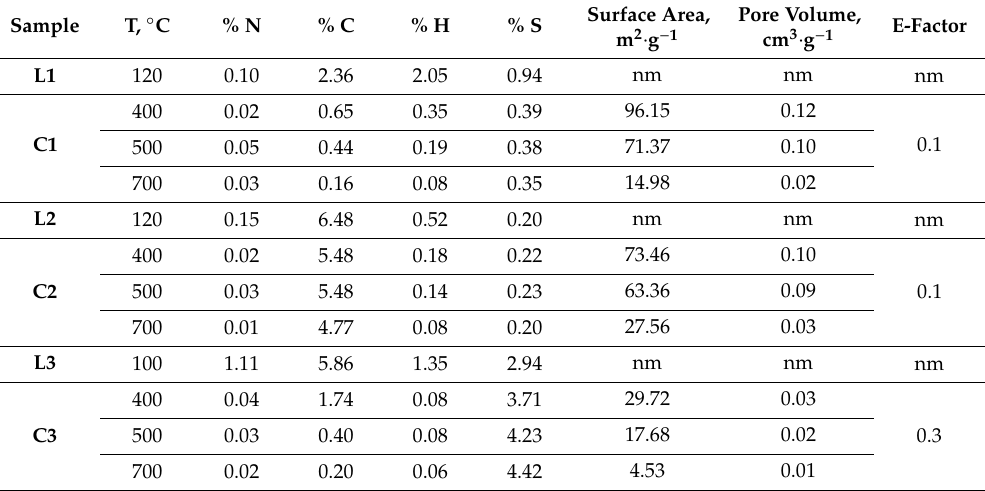
Table 1. Elemental analysis and physical properties of dried residual sludges (L1–L3) and catalytic material synthesized (C1–C3).